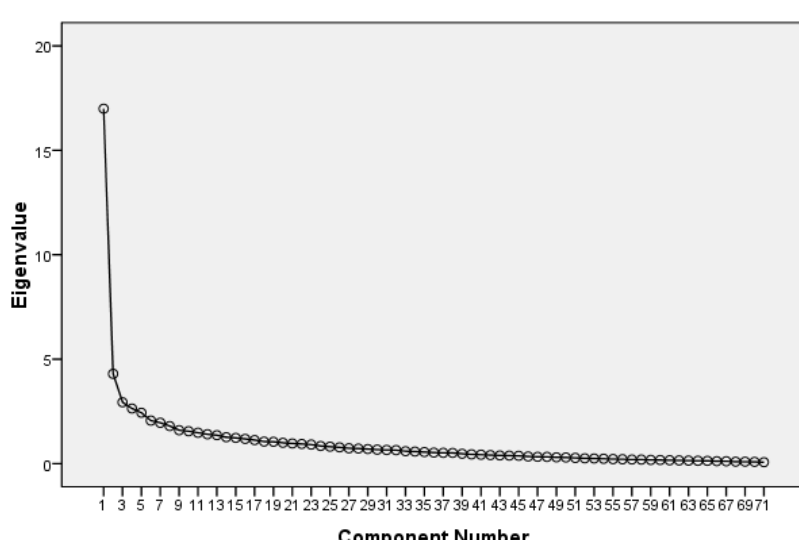
Figure 2. The scree plot of the items in exploratory factor analysis.